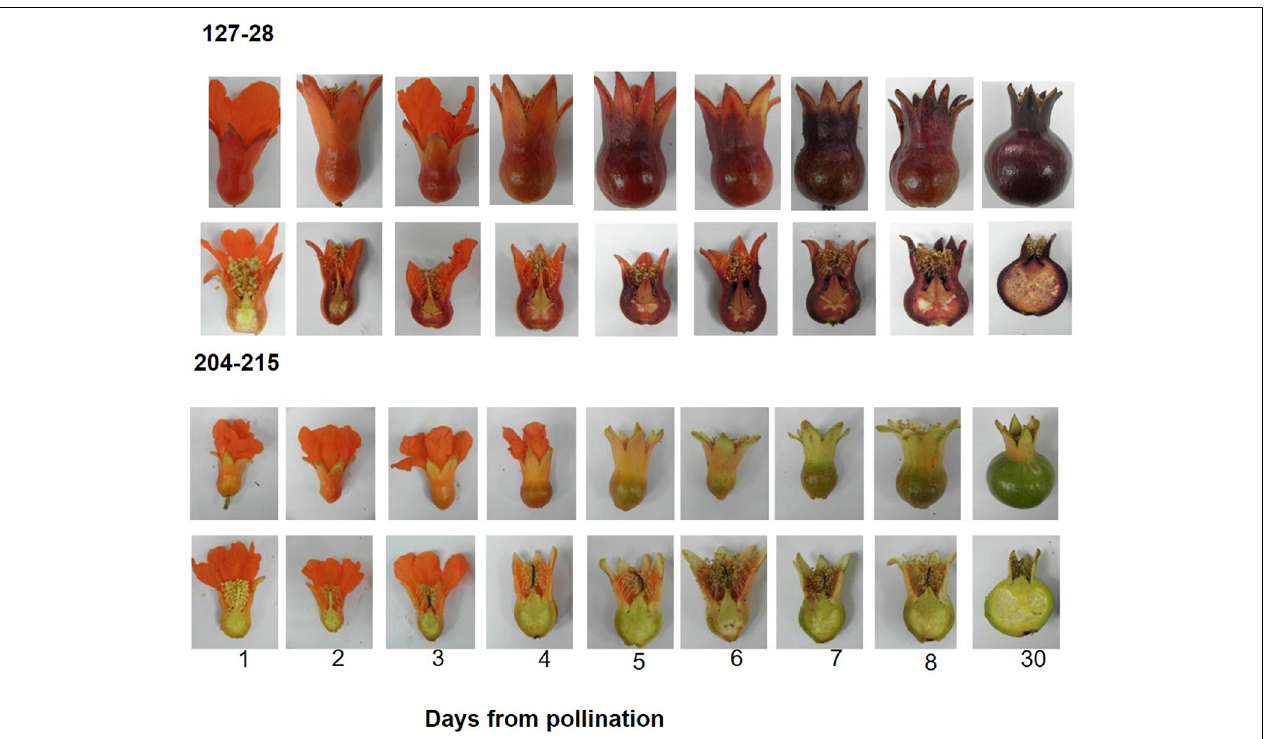
FIGURE 3 | Timing of color accumulation in peel skin following hand pollination in the ‘Black’ pomegranate (P.G. 127-28) and a “red” variety (P.G.204-215). Young fruitlets were collected every day after pollination for 8 days and then 30 days after pollination (stage 2). Whole and half fruitlets are presented in order to show color